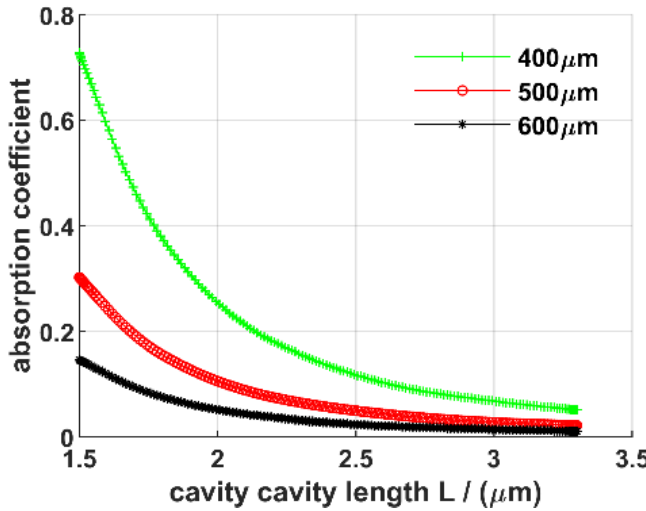
Figure 8. Influence of cavity length on absorption.